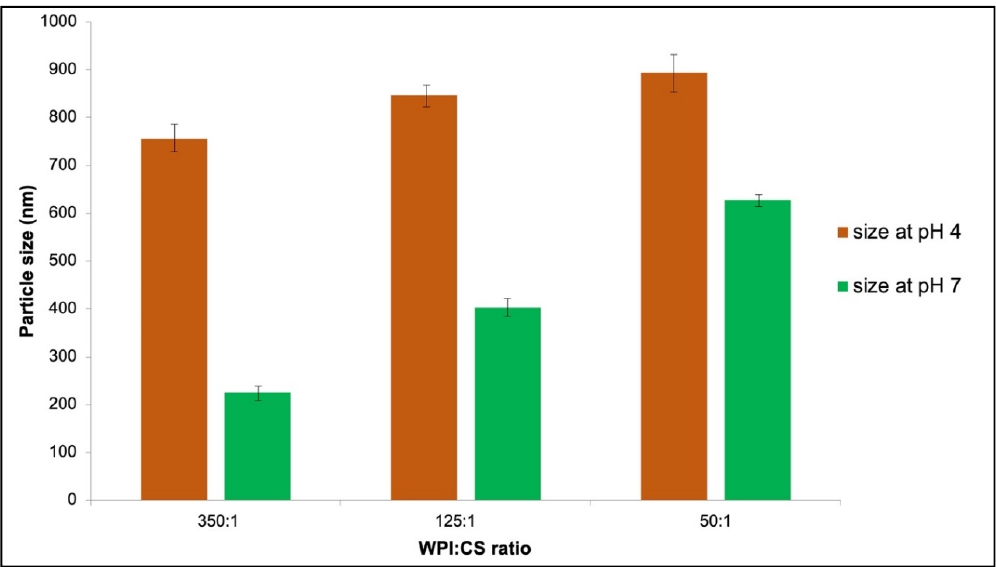
350:1 had similar color while the WPI/CS 50:1 showed noticeable color change. This is highlighted in Figure 12 where 50:1 LMW CS-Fe and 125:1 LMW CS-Fe changed color from orange to dark brown. As shown above, all samples contained similar amount of ascorbic acid which acts as antioxidant. Hence, this color change cannot be attributed to variable oxidation activity. Denaturing of whey protein isolate can also happen due to oxidative stress [31], which may contribute to this color change. This also highlights that using WPI/CS 350:1 has produced particles with optimum stability and encapsulation efficiency.